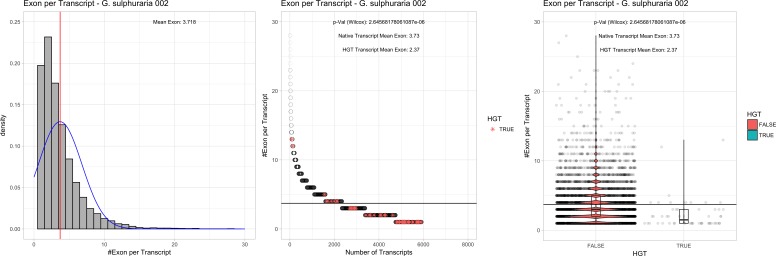
Exon/Intron – Galdieria sulphuraria 002: (Left) Mid) Cumulative %GC distribution of transcripts.Red line shows the average, blue line a normal distribution based on the average value. The data is categorical (genes have either one, two, three etc. exons) and does not follow a normal distribution. (Mid) Ranking all transcripts based upon their number of exons. Red ‘*' demarks HGT candidates. As the number of exons was not normally distributed, transcripts were ranked by number of exons. In order to resolve the high number of tied ranks (e.g. many transcripts have two exons) a bootstrap was implied by which the rank of transcripts sharing the same number of exons was randomly assigned 1000 times. Wilcoxon-Mann-Whitney-Test applied for the determination of significant rank differences between the native gene and the HGT candidate subset. (Right) Violin plot showing the number of exons per transcript distribution across native transcripts and HGT candidates.